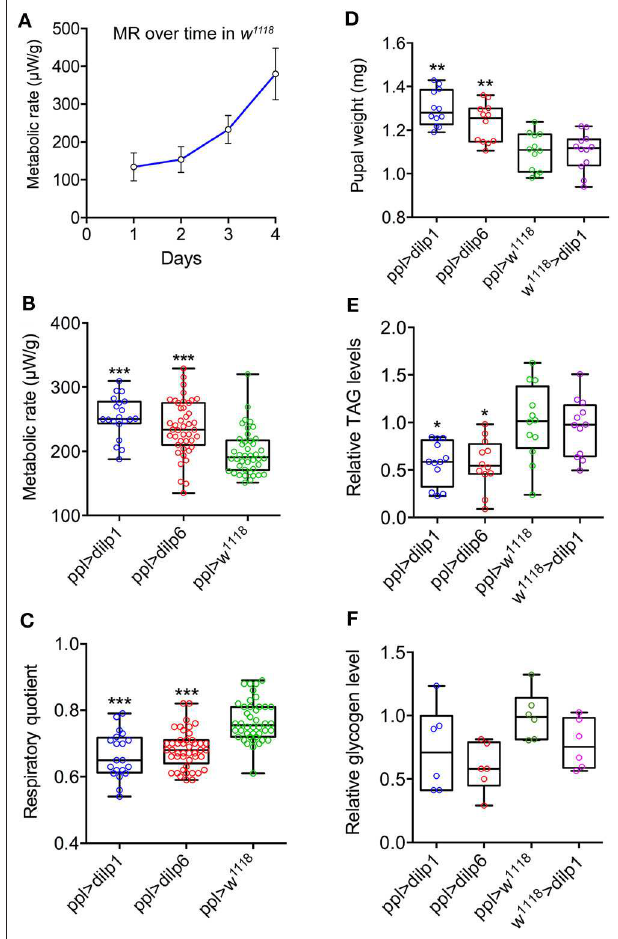
FIGURE 3 | Metabolic rate trajectories and respiratory quotients (RQs) during pupal development respond to dilp1 and dilp6 overexpression in the fat body. (A) Metabolic rate in w 1118 flies increased exponentially as a function of time. For the ensuing overexpression analysis, we studied the period 96–120h after pupation. Data are presented as means ± S.E.M, n = 20–47 flies from three independent replicates. (B) Metabolic rate was significantly elevated during this period in dilp1 and dilp6 overexpression flies ( ppl-Gal4 ) when compared to w 1118 flies. Data are presented as means ± S.E.M, n = 20–47 flies for each genotype from three independent replicates (*** p < 0.001, compared to w 1118 flies, as assessed by two-way ANOVA followed with Tukey’s test). Data are from both males and females as no difference was found in the ANOVA for sex. (C) RQ, reflecting catabolic energy substrate, was significantly lower in the overexpression flies when compared to the control flies and indicates a shift from mixed fuel catabolism (RQ = 0.7–0.8) to predominantly lipid catabolism (RQ < 0.7). Data are presented as means ± S.E.M, n = 20–47 flies for each genotype from three independent replicates (*** p < 0.001, compared to w 1118 flies, as assessed by one-way ANOVA followed with Tukey’s test). Data are from both males and females as no difference was found in the ANOVA for sex. (D) Four-day-old pupae (mixed male and female) were weighed (wet weight) before extraction and TAG determination. Overexpression of dilp1 and dilp6 both resulted in increased pupal weight. (E) Levels of TAG were measured in the pupae used for weighing in D. Overexpression of each dilp resulted in decreased TAG levels. (F) Glycogen levels in 4-day-old pupae (no significant changes). In (D,E) , 12 replicates per genotype with 4 pupae in each replicate (each data point represents 4 pupae); in (F) , 6 replicates per genotype with 4 pupae in each replicate (* p < 0.05, ** p < 0.01, one-way ANOVA followed by Tukey’s